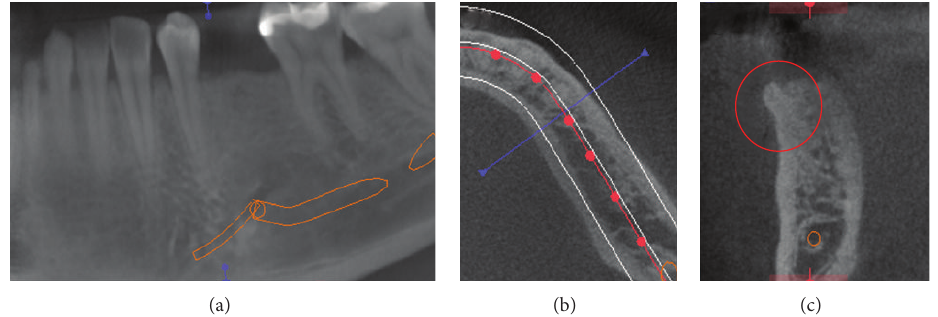
Figure 1: Panoramic radiograph. Note that it is aware of the presence of supernumerary tooth (a). Location through computed tomography. The blue line illustrates the parasagittal section which locates the supernumerary tooth (b). Supernumerary tooth (red circle) located in relation to the buccal cortex (c).